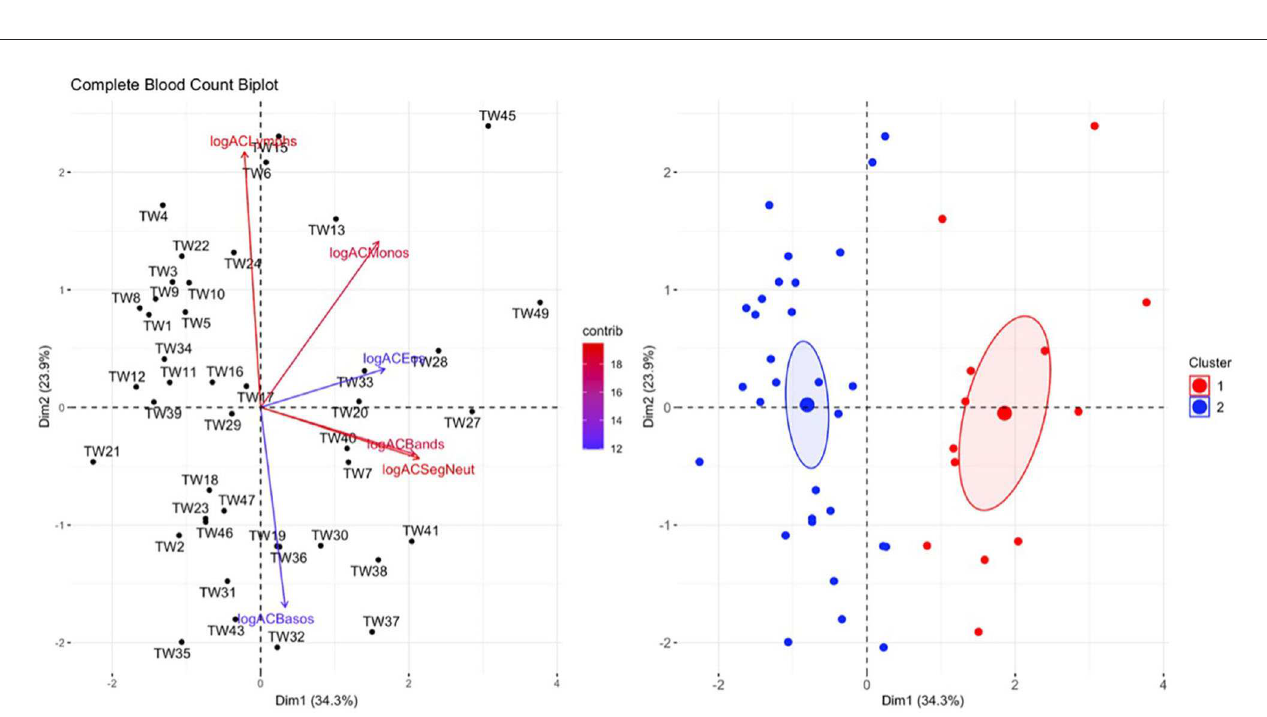
FIGURE7 Principal component analysis (PCA) for the complete blood count (CBC) data. In the plot on the left, individuals in the same space as the arrowhead had higher values of the blood parameter, and individuals in the opposite direction had lower levels of the blood parameter. The length and color of each arrow represent the strength of the relationship. The plot on the right is showing how the individuals clustered together using K means clustering. The majority of Taricha granulosa in cluster 1 (red) were Batrachochytrium salamandrivorans ( Bsal ) infected, clinically diseased individuals, and the majority of T. granulosa in cluster 2 (blue) were controls or Bsal -infected, non-clinically diseased individuals. logACLymphs, Absolute count of lymphocytes; logACMonos, absolute count of monocytes; logACEos, absolute count of eosinophils; logACBands, absolute count of band neutrophils; logACSegNeut, absolute count of segmented neutrophils; logACBasos, absolute count of